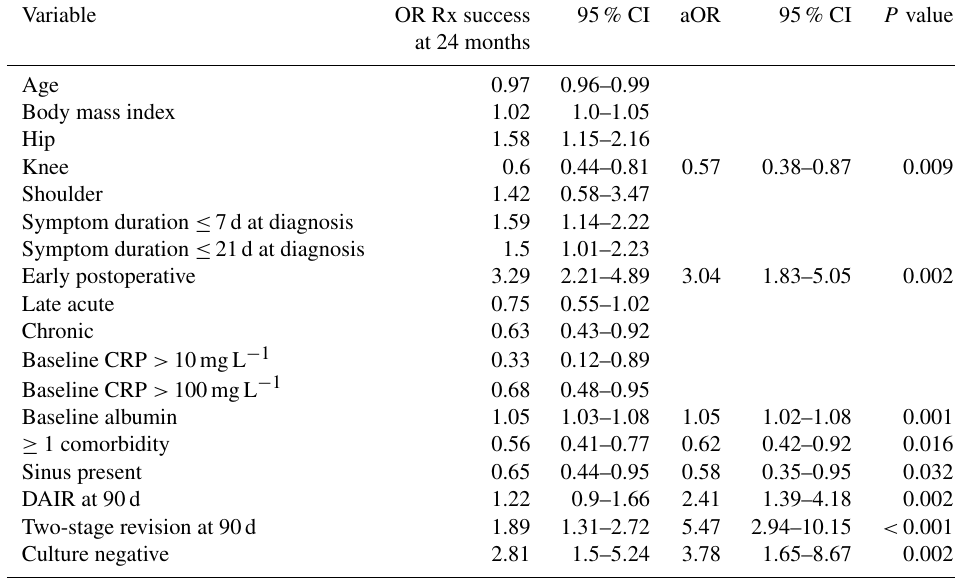
Table 5. Independent predictors of treatment success at 24 months ( n =